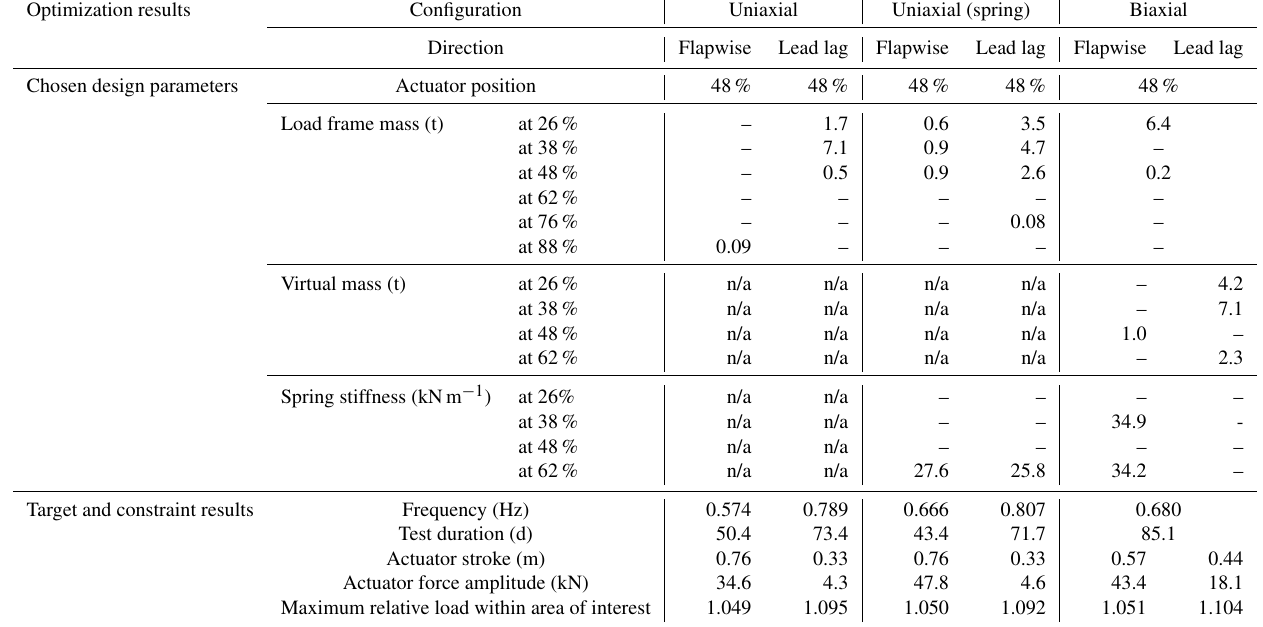
Table 2. Summary of the optimized setups. n/a: not applicable. Optimization results